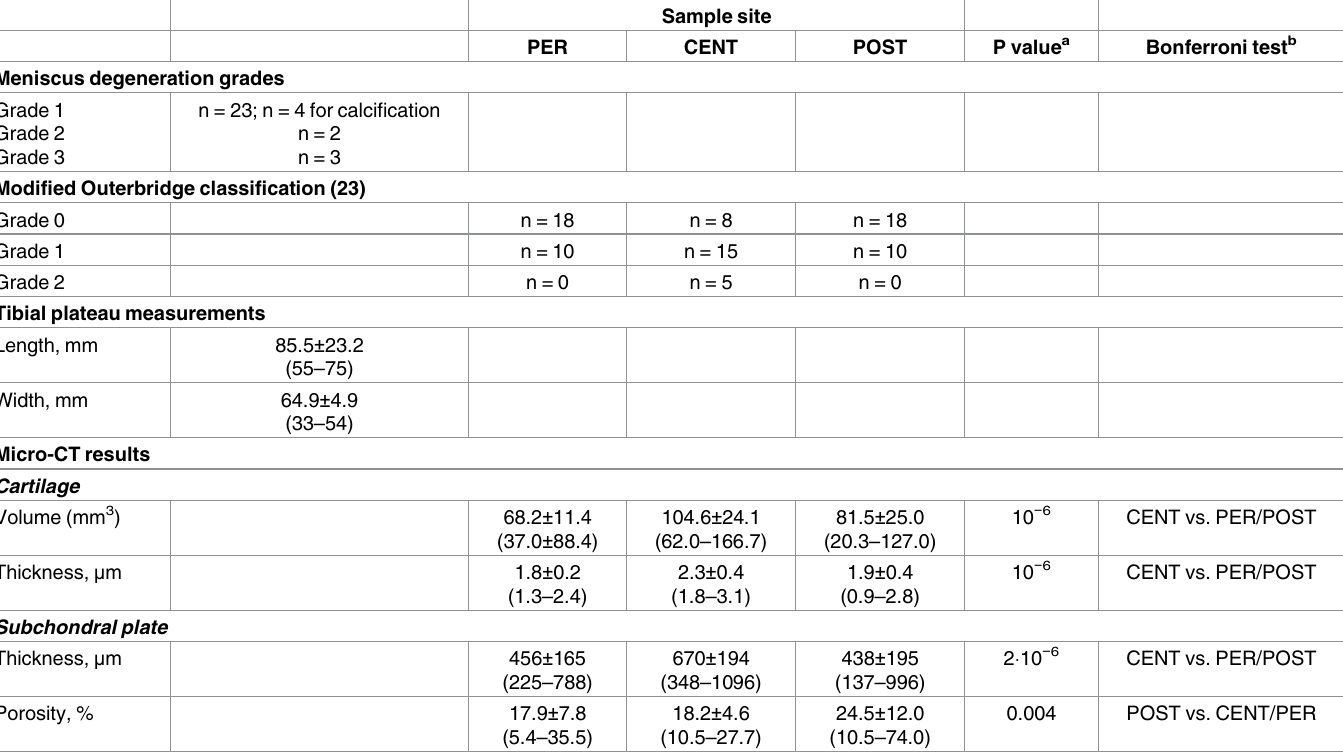
Table 1. Meniscus, cartilage classifications and micro-CT results for cartilage and subchondral plate in all knees (n = 28) by sample site.